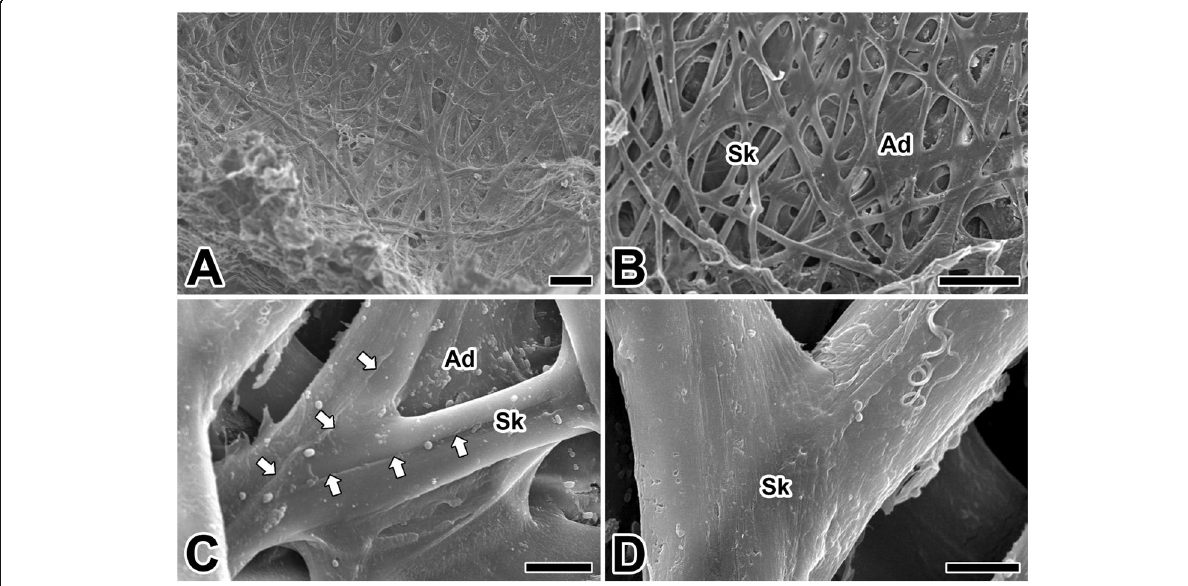
Fig. 3 a - d Scanning electron micrographs of the composite silken case produced by the silk ribbons (Sk) and adhesive coats (Ad) of the caddisworm H. nigrovittatus. Arrows indicate the midline traces of fibrillar fusion. Scale bars indicate 100 μ m ( a, b ), 10 μ m ( c ), and 5 μ